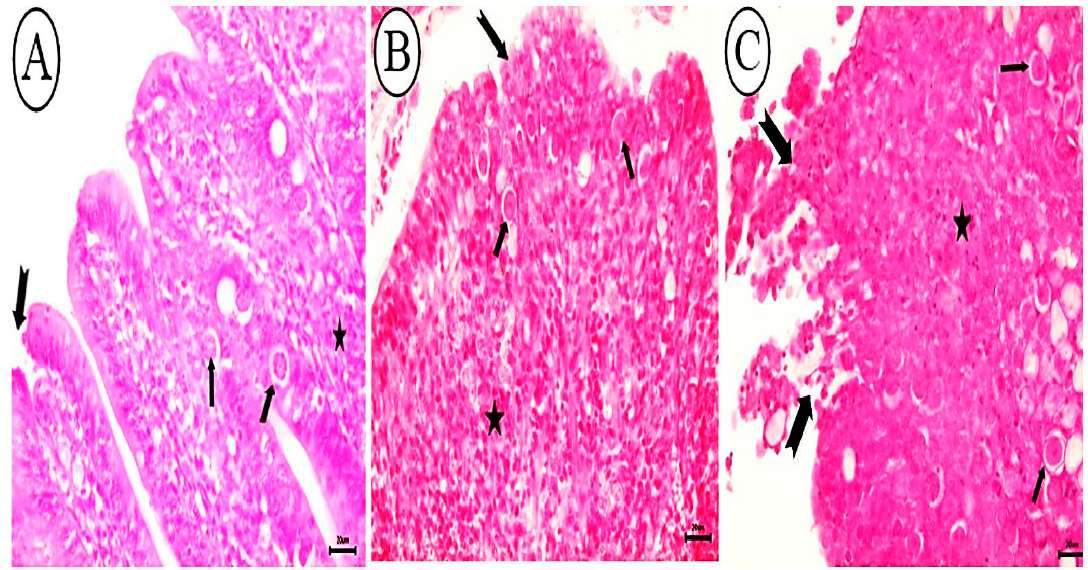
Figure 7. Photomicrograph depicting histopathological characteristics of cecal tissues. ( A ). Birds infected with allicin-treated oocysts exhibited a significant reduction in the number of coccidial stages (arrow), accompanied by slight epithelial necrosis at villar tips (notched arrow) and infiltration of mononuclear cells (star). ( B ) Birds infected with garlic extract-treated oocysts display reduced epithelial necrosis (notched arrow), coccidial stages (arrow), and mononuclear cells in the lamina propria (star). ( C ) Birds infected with KOH-treated oocysts exhibiting villar necrosis (notched arrow), mononuclear cells (star), and parasitic stages in the lamina propria (arrow), H&E stain, bar = 20 µ